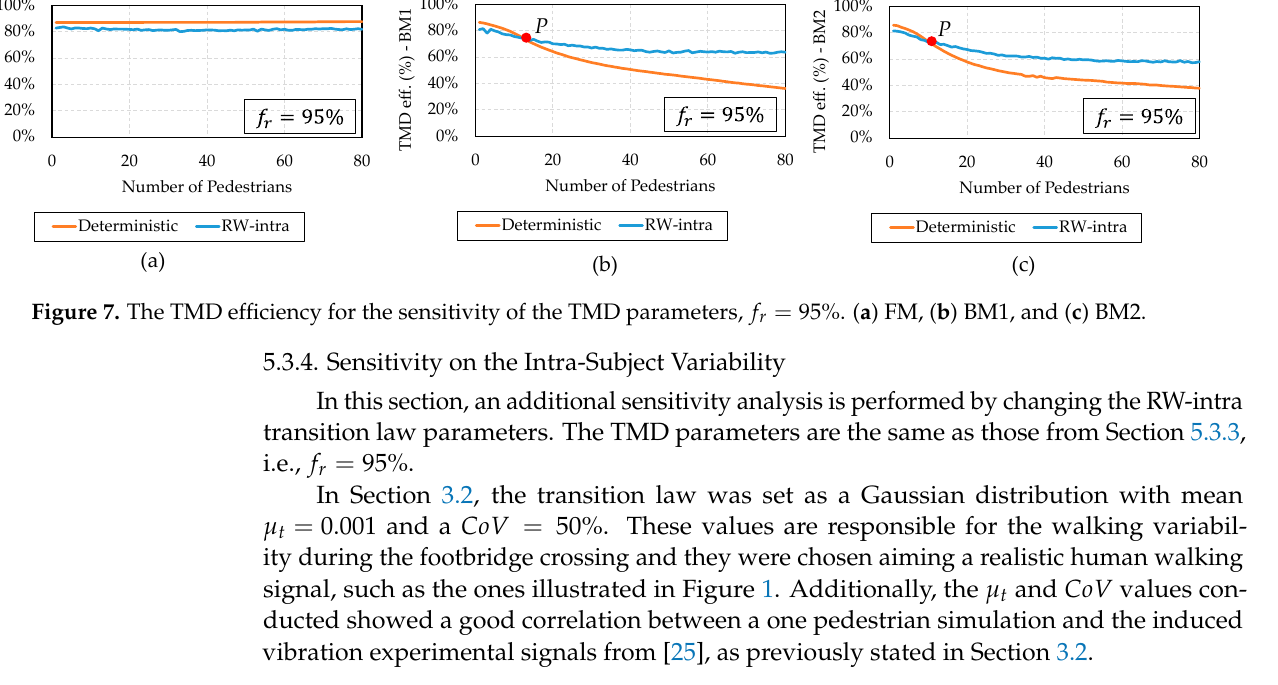
Figure 7. The TMD efficiency for the sensitivity of the TMD parameters, 𝑓 (cid:3045) = 95% . ( a ) FM, ( b ) BM1, and ( c ) BM2.